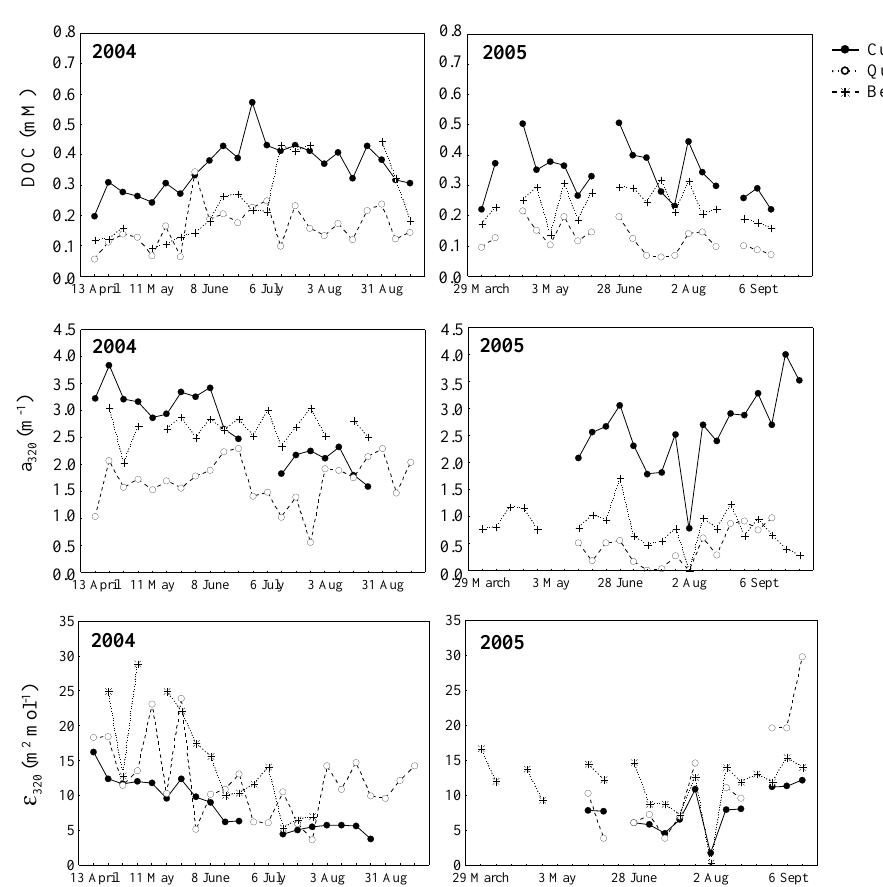
Fig. 4. Dynamics of dissolved organic carbon (DOC), absorption coefficients at 320nm ( a 320 ) and molar absorption coefficients at 320nm ( ε 320 ) during the stratifications periods of 2004 and 2005 in the three study